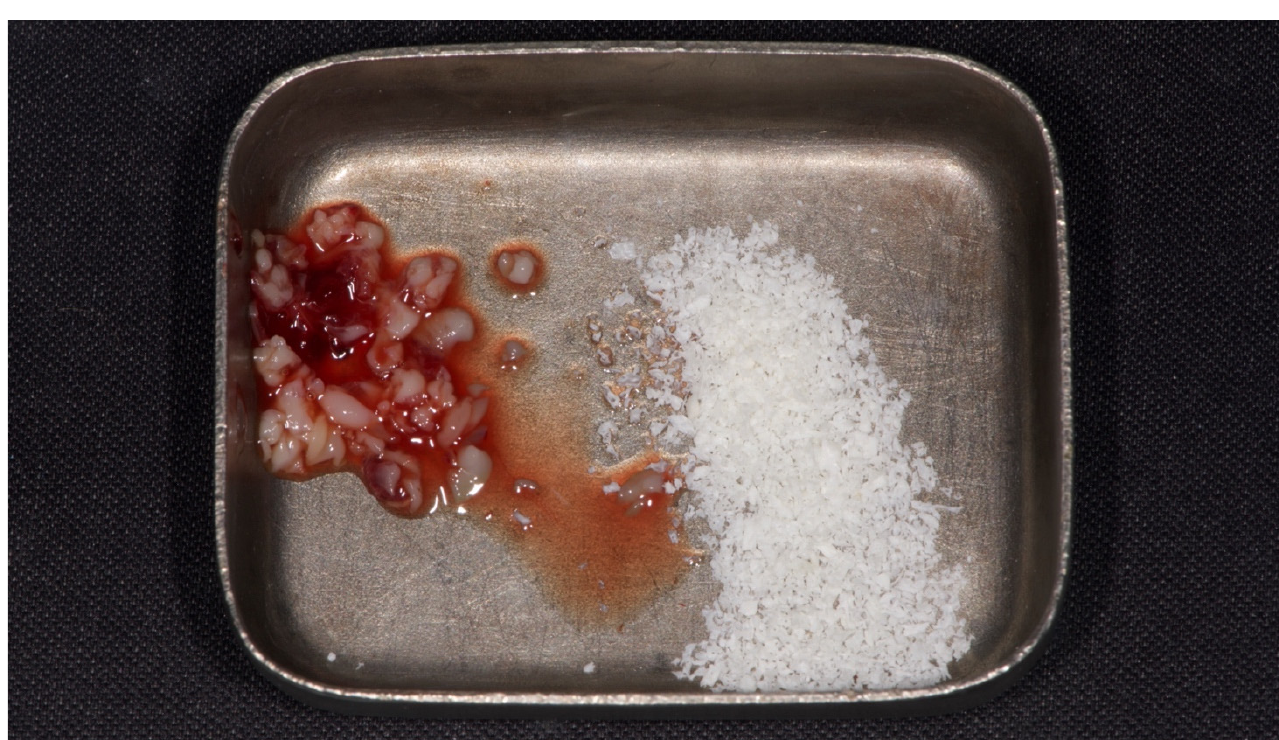
Figure 3. L-PRF (left) and decellularized bovine compact bone from bovine femur (right).